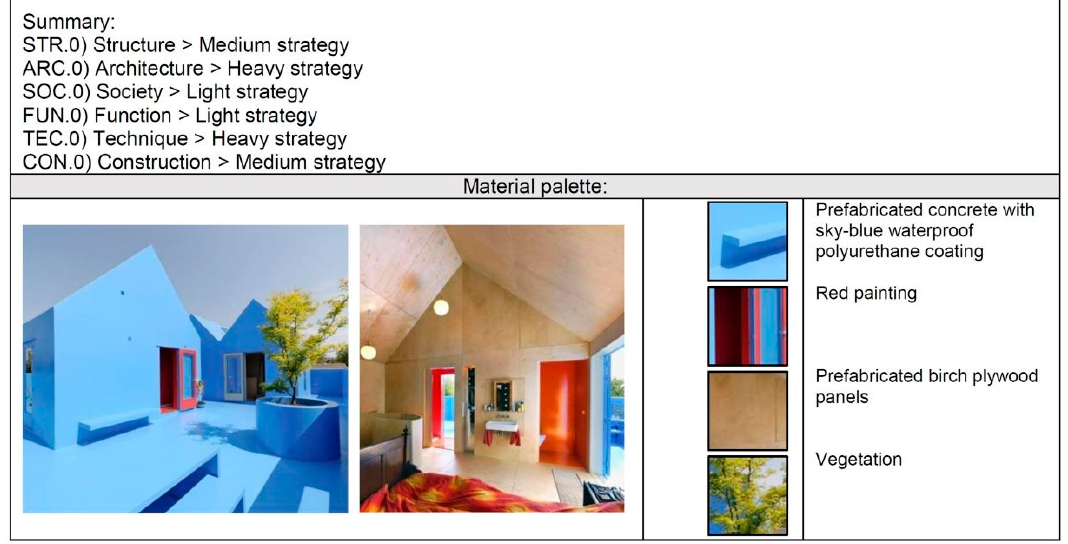
Figure 2. Example of data sheet.